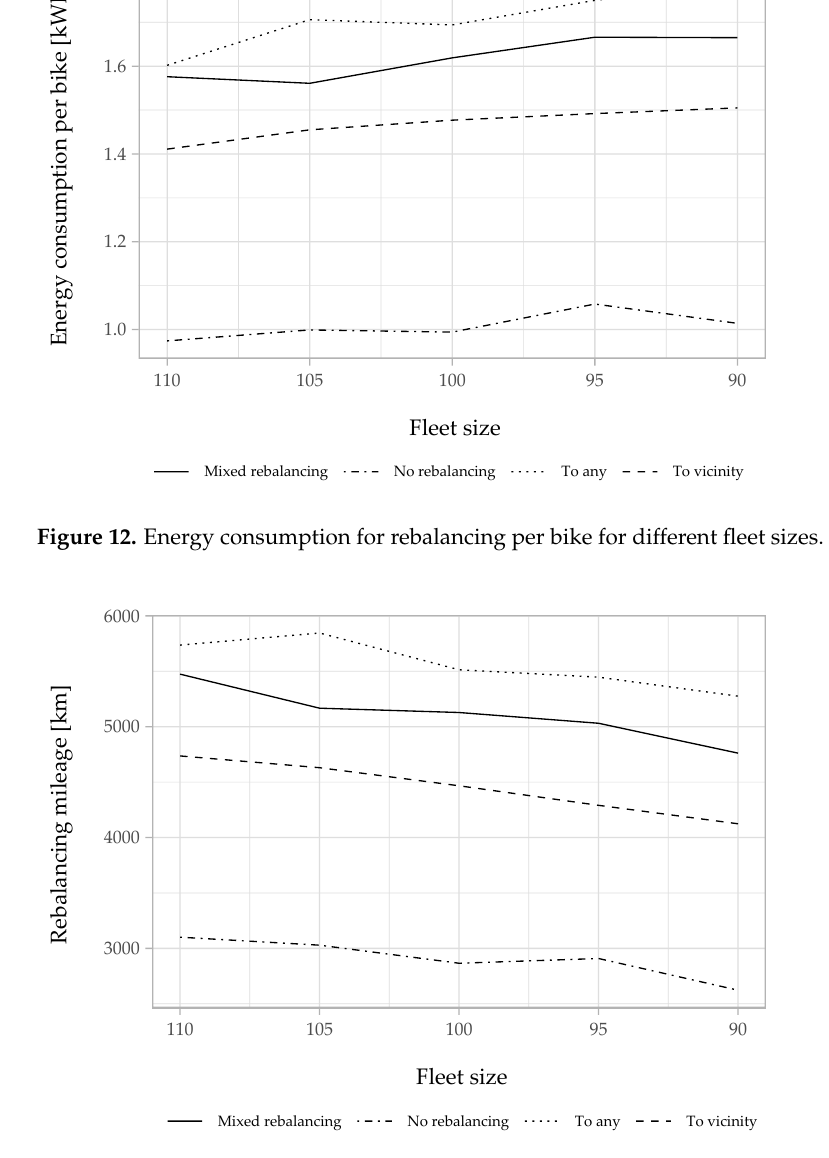
Figure 13. Rebalancing mileage traveled for different fleet